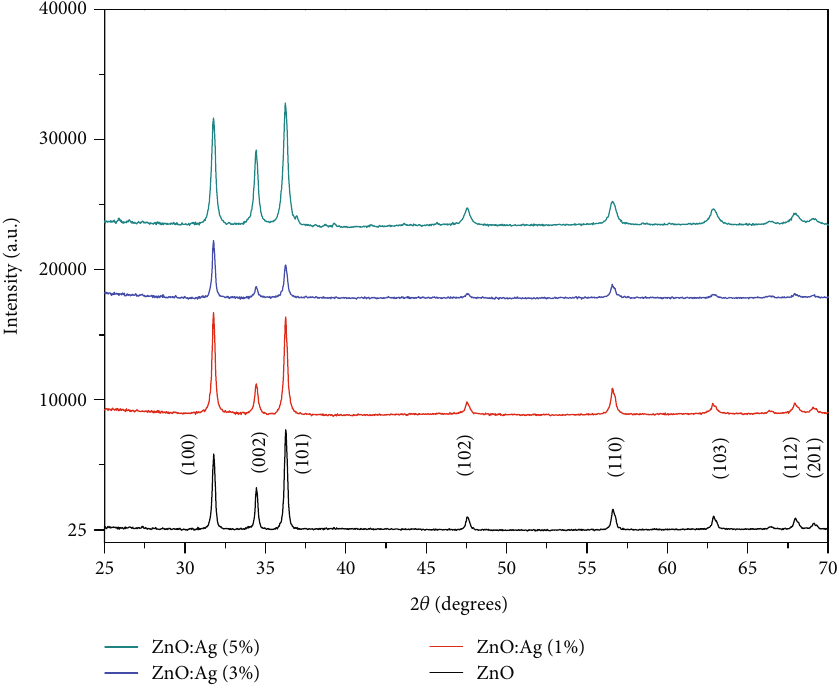
Figure 5: X-ray di ff raction patterns for both ZnO and ZnO:Ag thin fi